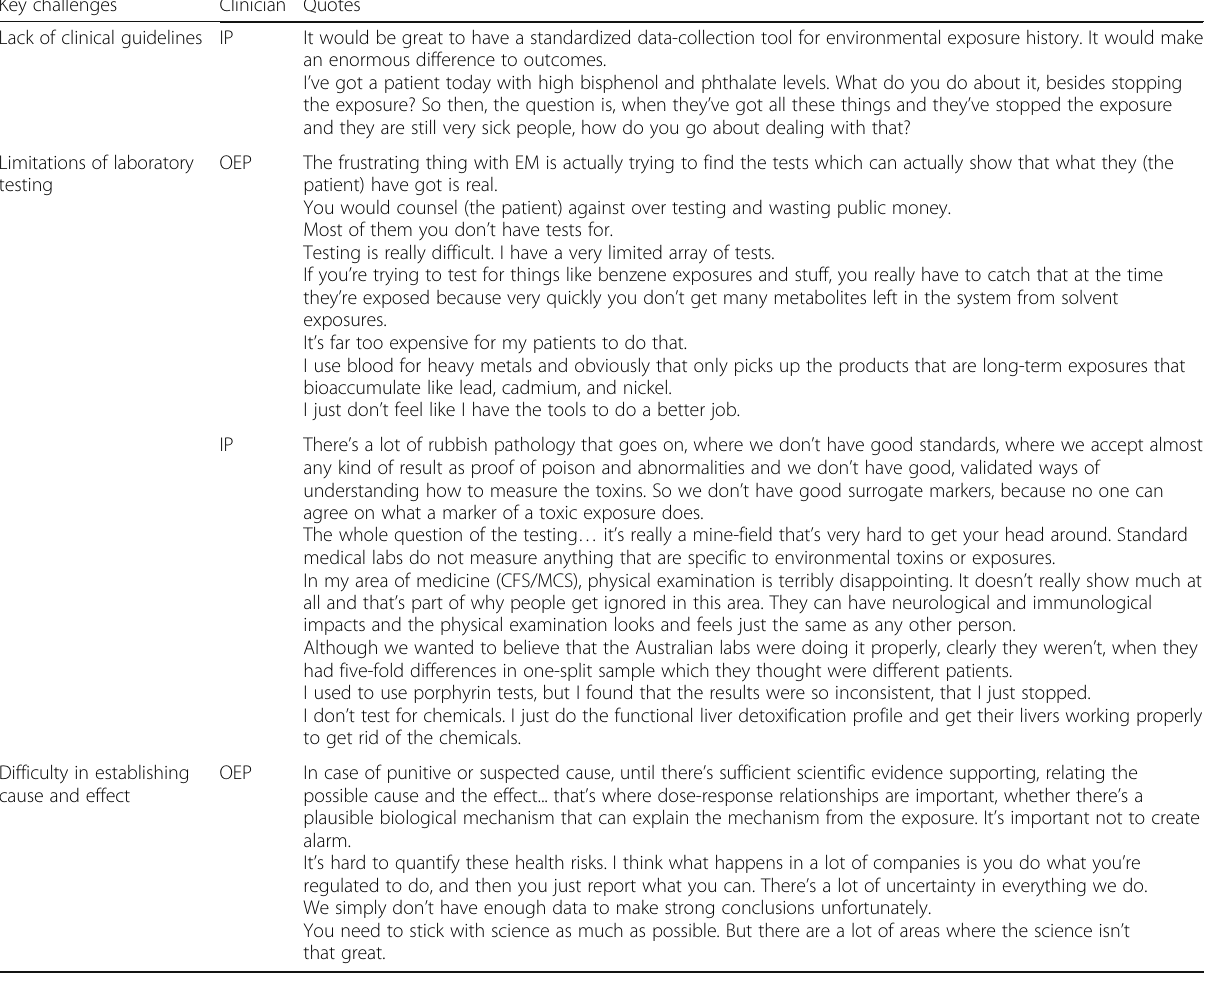
Theme 4: Patients with environmental sensitivities are increasing, have unique phenotypes, are complex to treat and rarely regain full health Where IPs treated patients with chronic idiopathic envir- onmental sensitivities, OEPs were more likely to attribute symptoms to psychological factors on the basis that linear dose-response relationships could not explain their Table 2 Clinical assessment of toxicant exposures is challenging Key challenges Clinician